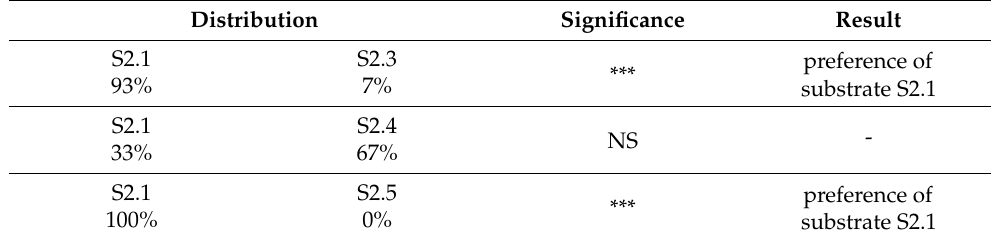
Table 6. Results of the avoidance test with the earthworms Eisenia andrei exposed to a second set of tested substrates for 48